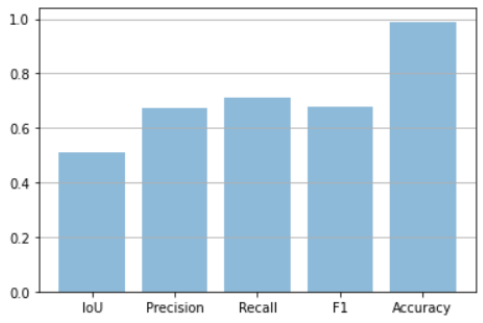
Figure 2. Computed metrics on the test